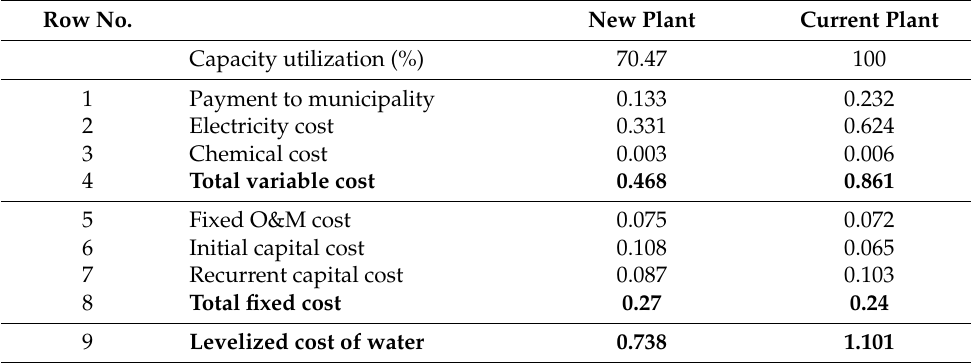
Table 6. Levelized financial costs of water produced when operating at different average levels of capacity in 2022 prices, USD/m 3